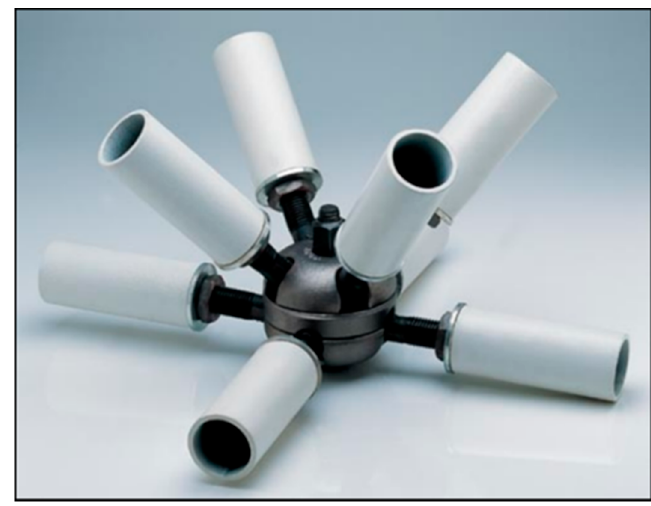
Figure A5. Vestrut node, from [29].